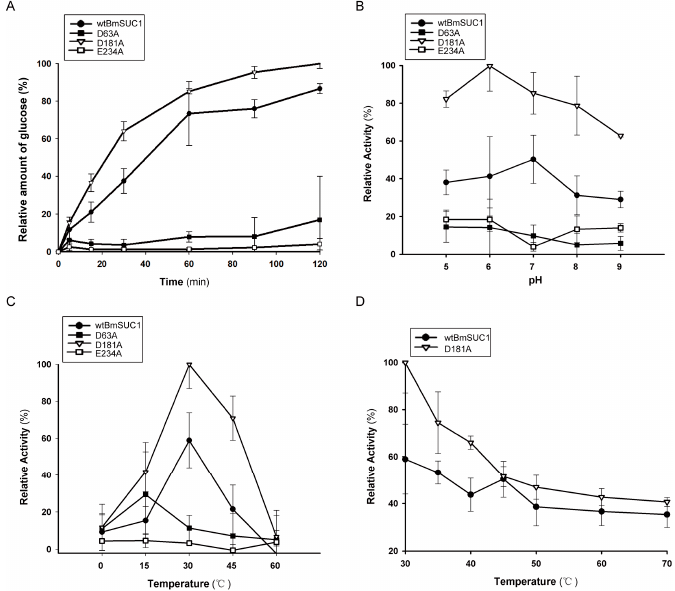
Figure 3. Comparison of enzymatic properties of wtBmSUC1 and mutants. ( A ) Influence of reaction time on hydrolysis activity; ( B ) Influence of pH on hydrolysis activity; ( C ) Influence of reaction temperature on hydrolysis activity; ( D ) Thermostability profiles of wtBmSUC1 and D181A. The hydrolysis activity was measured in 200 µ L of culture mixture using sucrose as the substrate. Vertical bars indicate the mean ± SD ( n = 3).